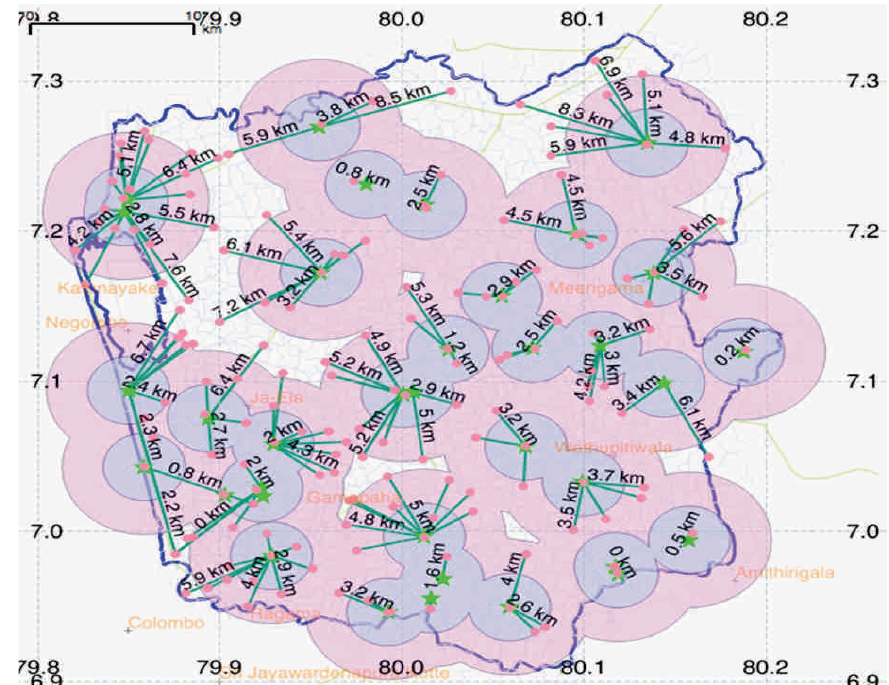
Figure 1: Map of Gampaha district showing 2.5 km (Blue) and 5 km (pink) buffers around dental clinic locations (Green stars) and the distance from each MCH clinic (pink dots) to the nearest public dental clinic in